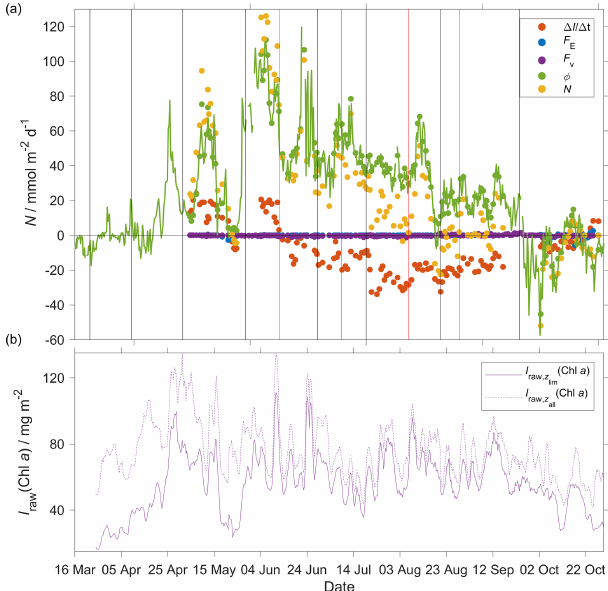
Figure 13. (a) Components of the N (O 2 ) calculation: (cid:49)I( O 2 )/(cid:49)t (red), E (O 2 ) (blue), F v (O 2 ) (violet), Φ (O 2 ) (green) with k w (O 2 ) weighted over 50d, N (O 2 ) (yellow). (b) Chl a inventory in the top ( Chl a) (violet). Chl a inventory for the whole water 45m, I raw ,z lim ( Chl a) (dotted violet line). The vertical black lines column, I raw ,z all represent each glider transect. Between the two vertical red lines, the glider was in the NCC